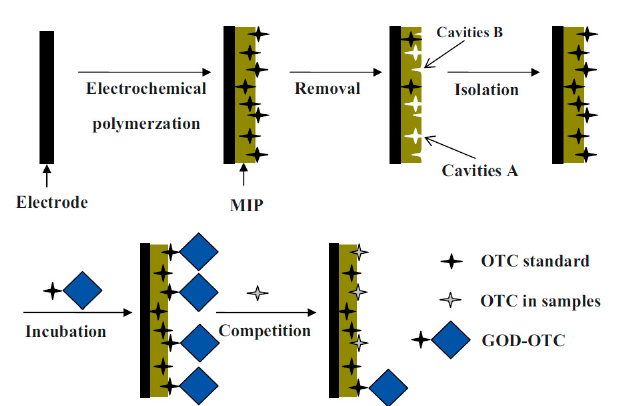
Figure 6. Schema of MIP preparation for oxytetracycline (OTC) and the principle of detection based on the glucose oxidase tracer (GOD–OTC). Reprinted by permission from [92].